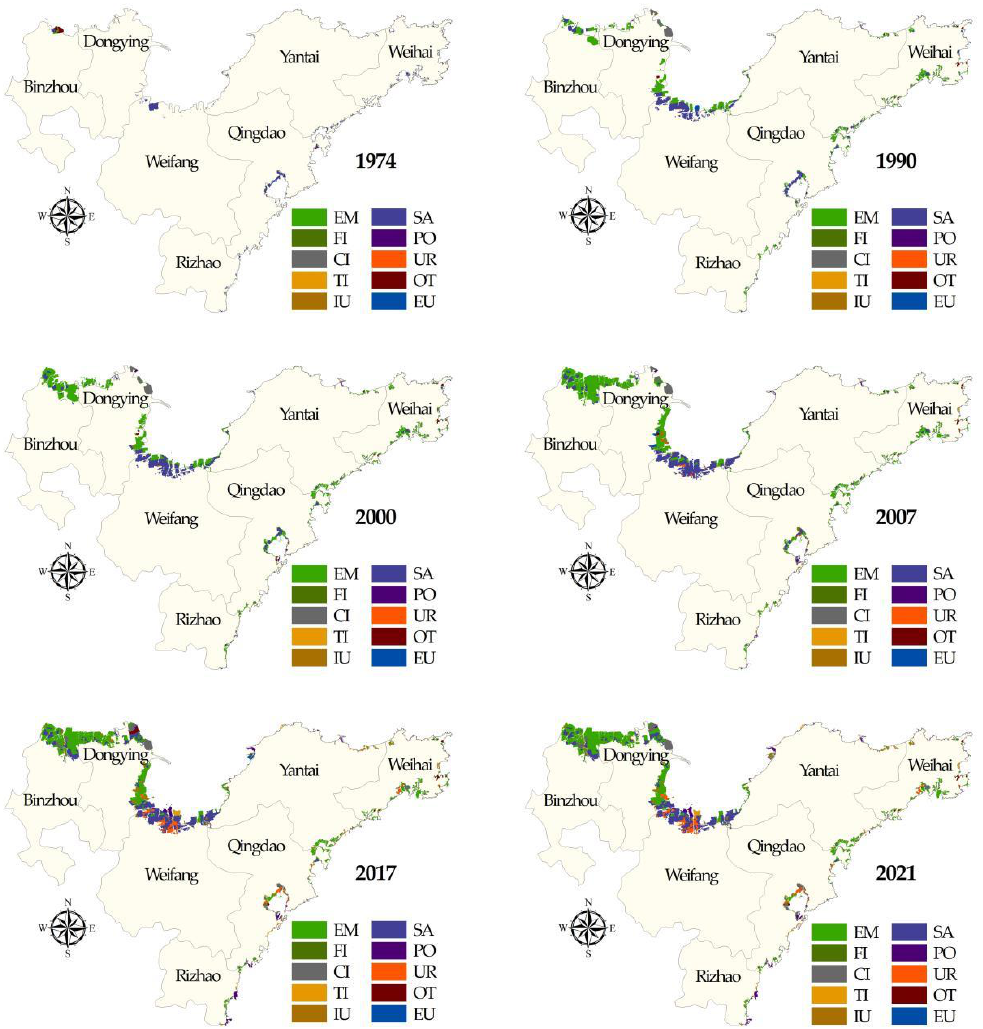
Figure 2. Reclamation maps in Shandong coastal area based on remote sensing techniques.